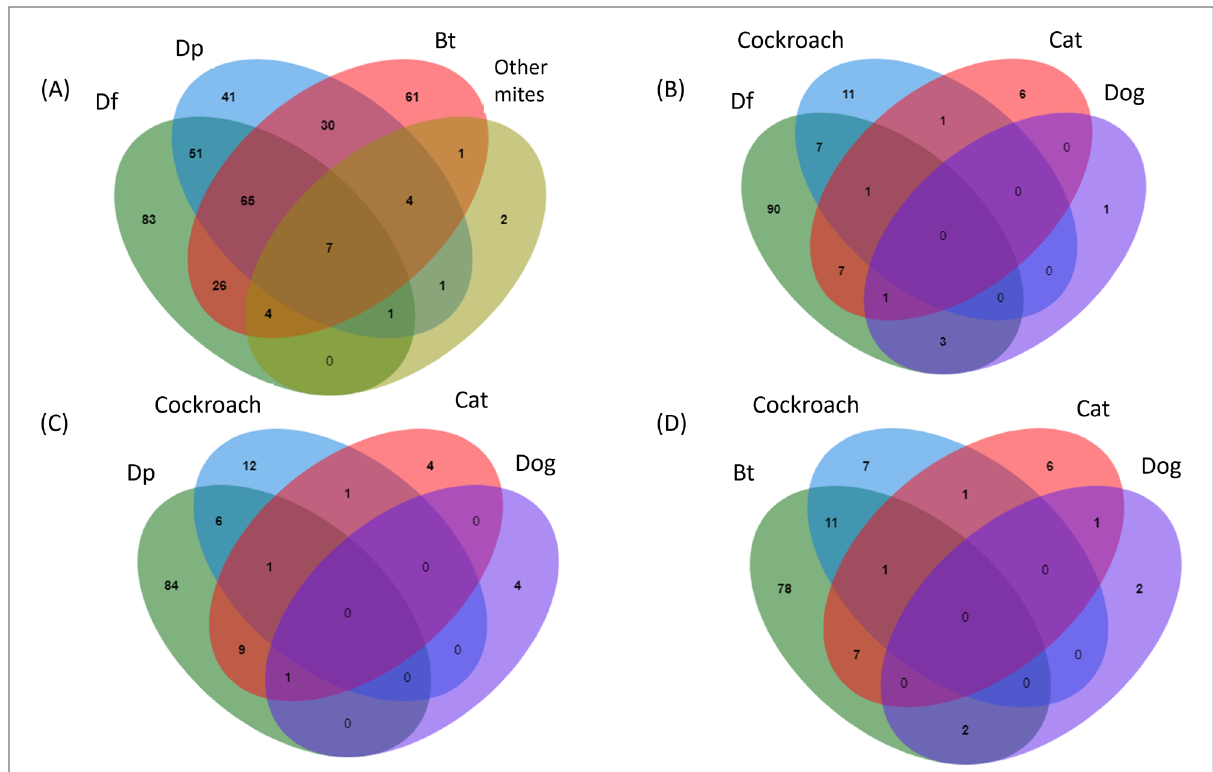
FIGURE 2 Patterns of polysensitization between the inhalant allergens. Venn diagrams showed the ( A ) polysensitization between Dp, Df, Bt and storage mites, and polysensitization between Dp ( B ), Df ( C ), and Bt ( D ) with extracts from cockroach, cat and dog hair. Bt, Blomia tropicalis; Df, Dermatophagoides farinae; Dp, Dermatophagoides